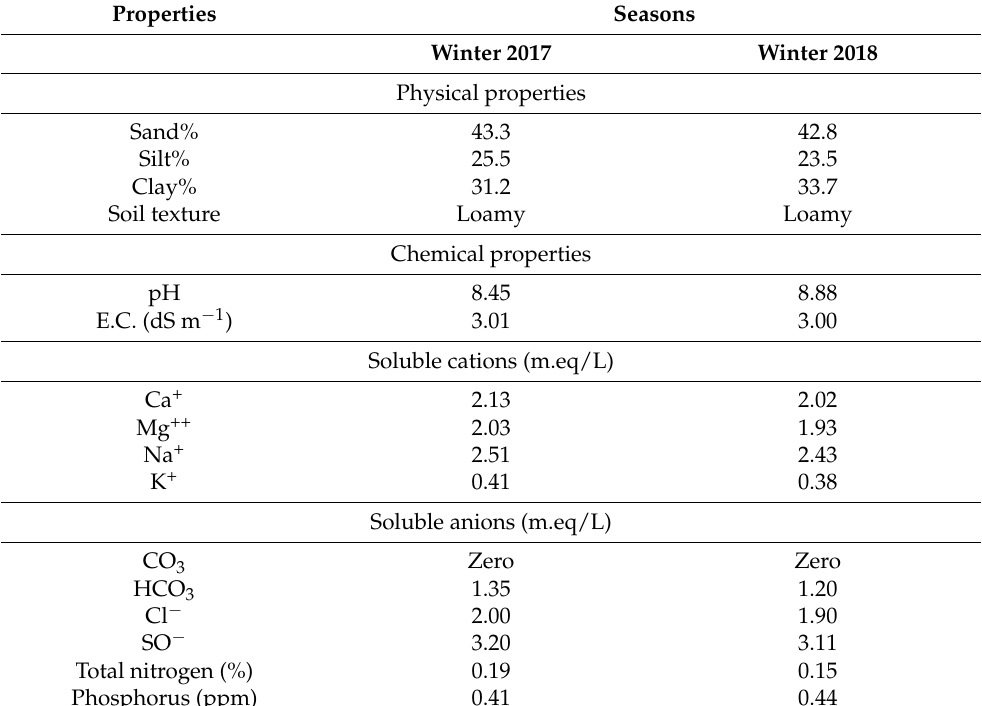
Table 3. Soil physical and chemical properties of the experimental sites during the two growing seasons of 2017 and 2018.